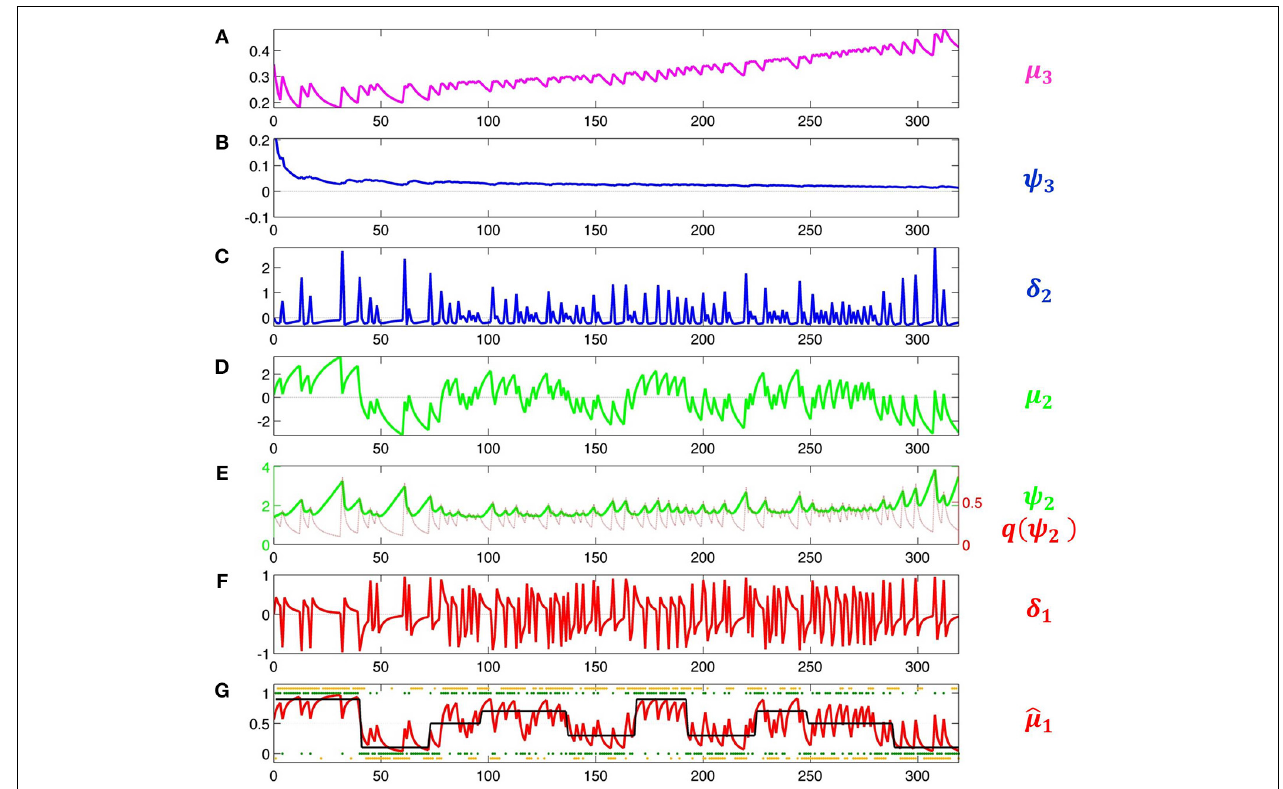
FIGURE 5 | Model inversion. Maximum-a-posteriori parameter estimates are μ (0) 2 = 0 . 87, σ (0) 2 = 1 . 20, μ (0) 3 = − 0 . 65, σ (0) 3 = 0 . 88, κ = 1 . 32, ω = − 0 . 71, and ϑ = 0 . 0023. These parameter values correspond to